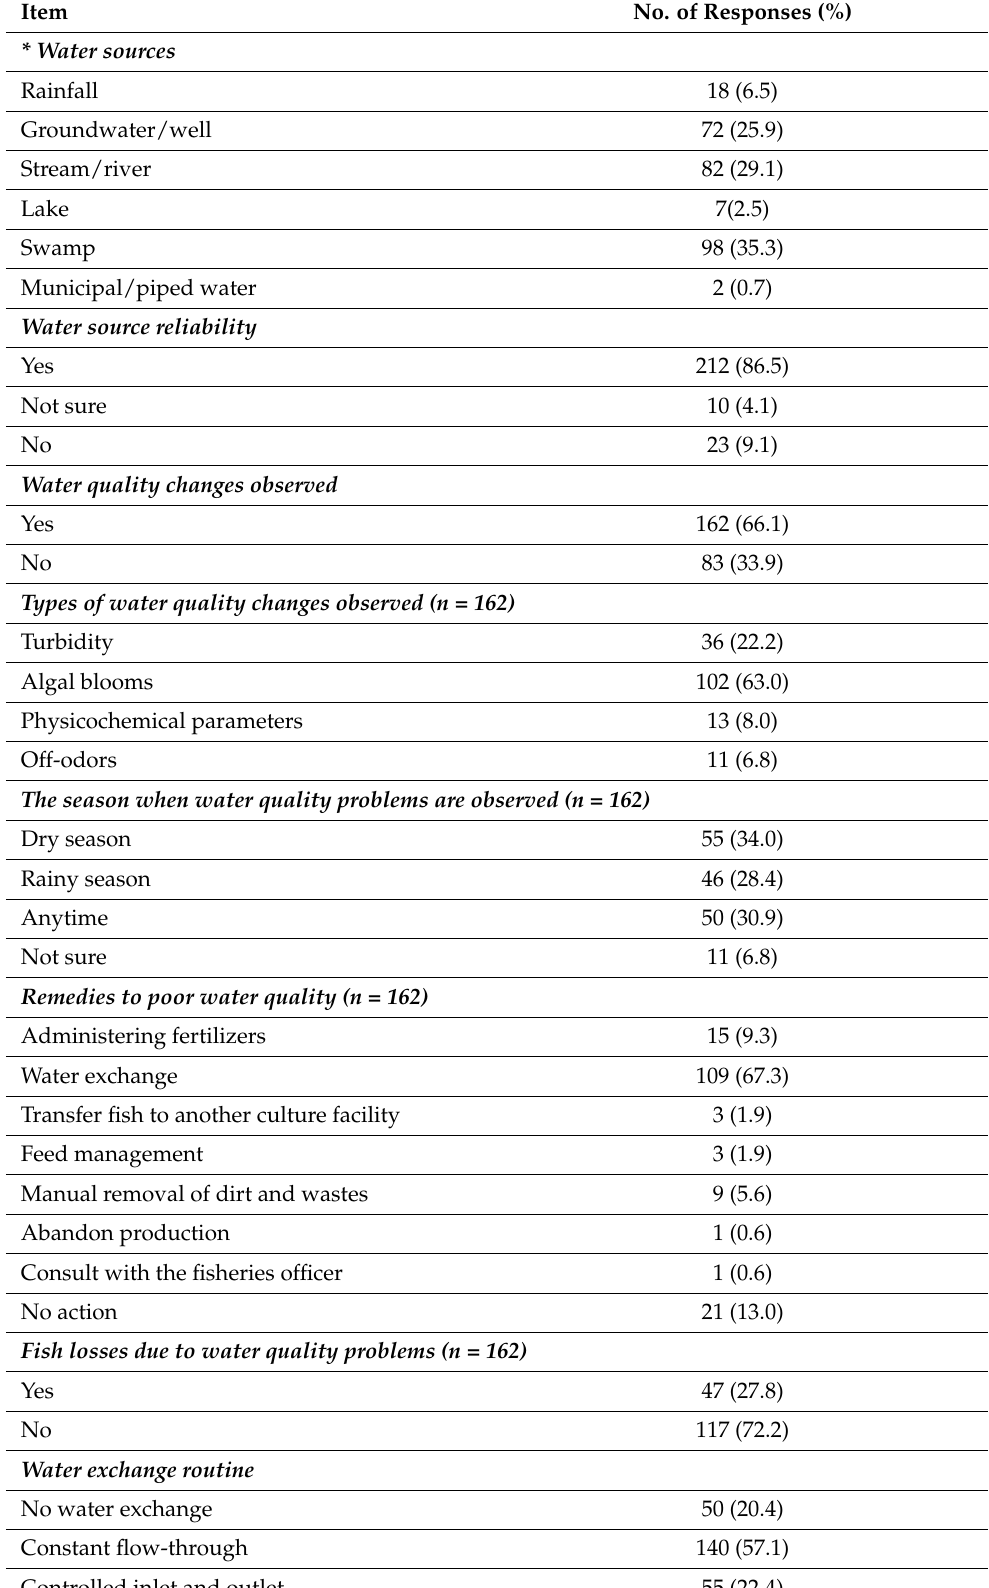
Table 3. Water resources and water quality dynamics of the fish farms in the Rwenzori